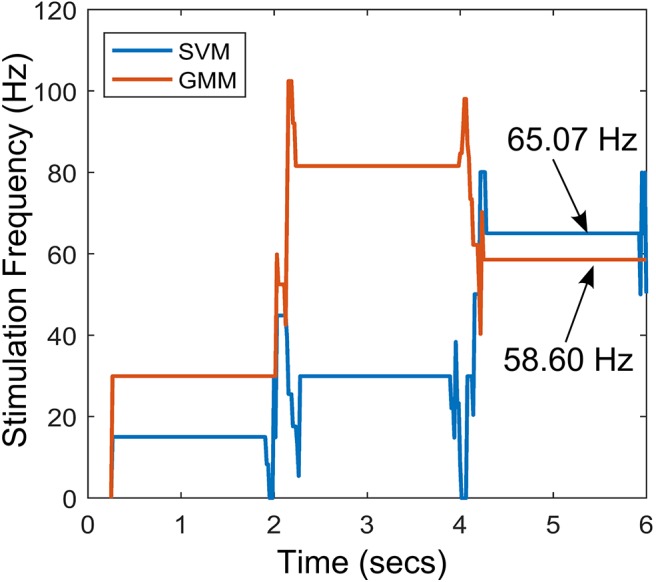
Stimulation profile for the state transition shown in Figure 9.